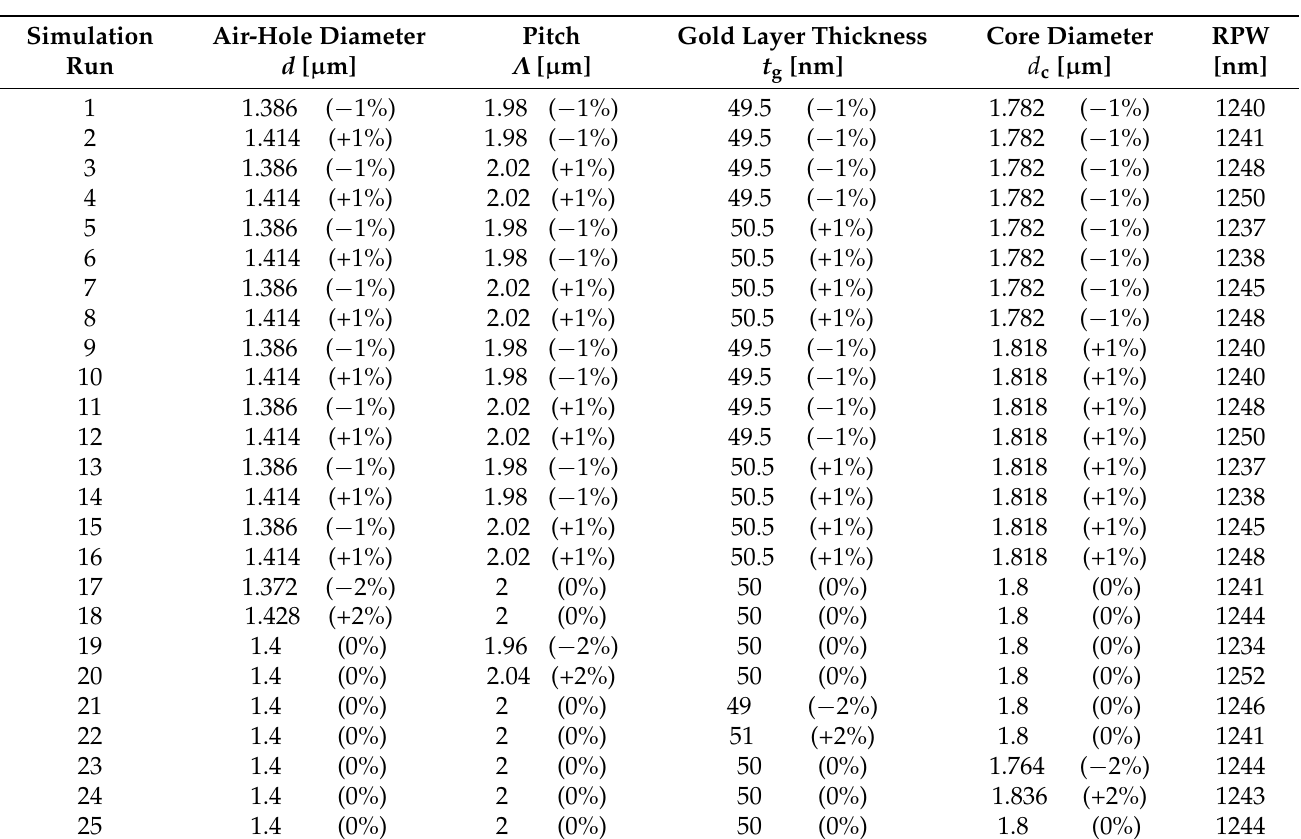
Table 5. FEM Simulations for 5-Level 4-Parameter ( ± 2% variations) DoE CCD Analysis.